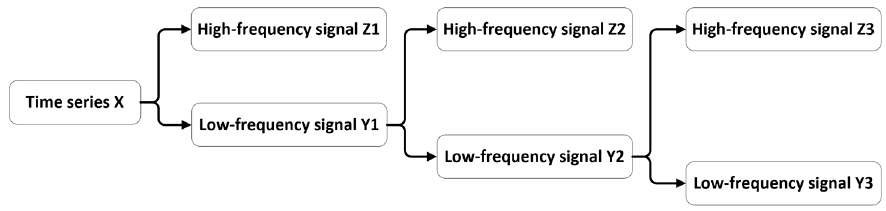
Figure 4. The process of wavelet decomposition and